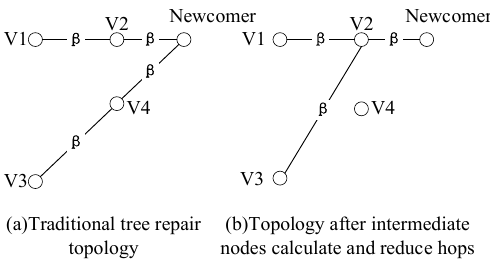
Figure 3. Topology after intermediate nodes calculate and reduce hops.